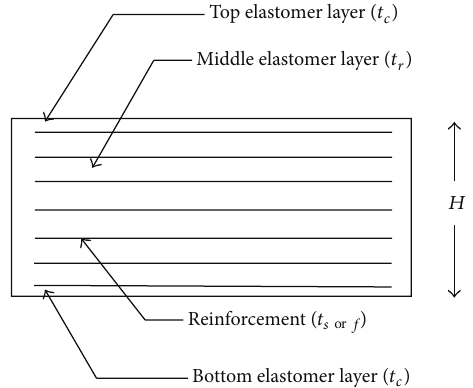
Figure 1: Schematic view of bearing